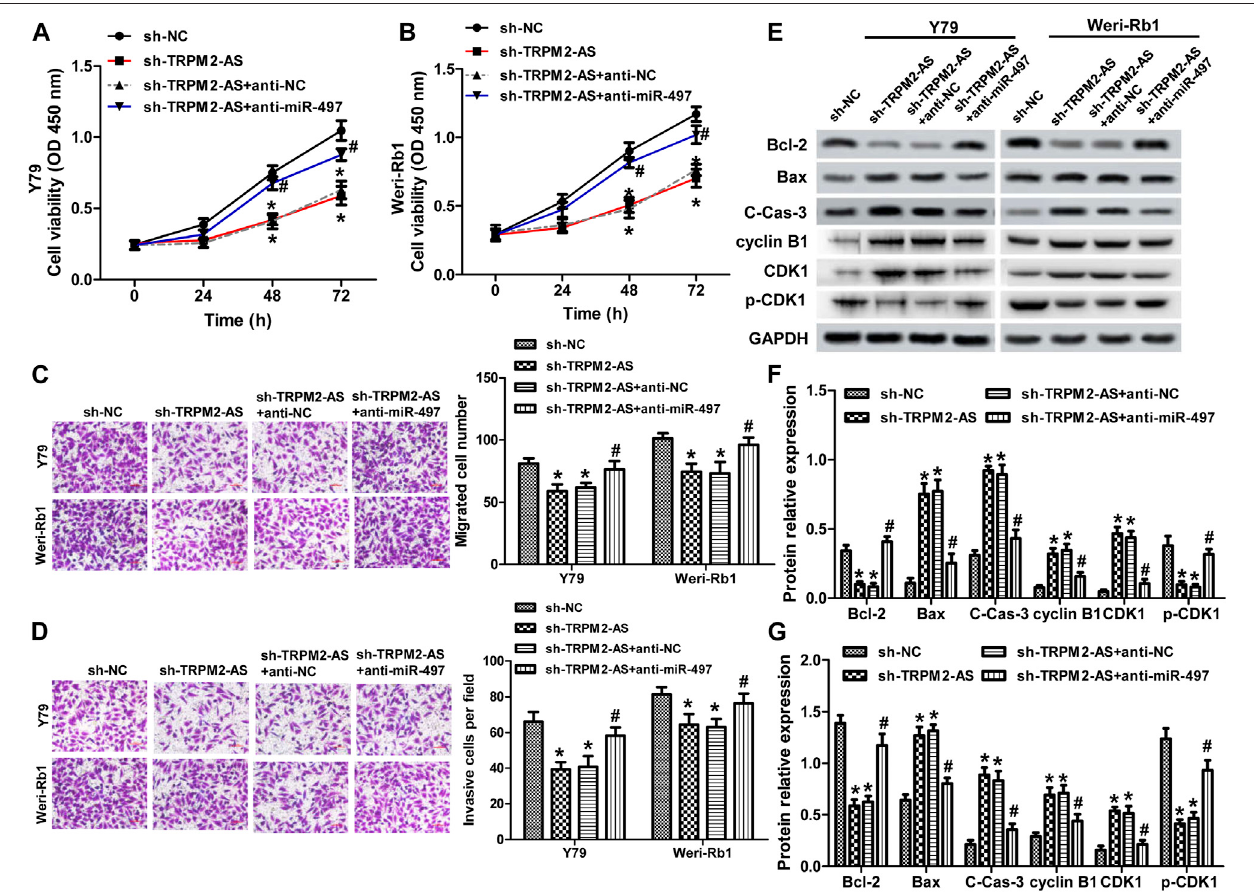
FIGURE4| miR-497inhibitorattenuatesTRPM2-ASknockdown onRBmalignantphenotypes.Y79 (A) andWeri-Rb1 (B) cellsweretransfectedwithTRPM2-AS/ control shRNA with or without miR-497/control inhibitor. And, cell proliferation was determined by CCK-8 assay. The migration (C) and invasion (D) of both RB cells under different treatments were assayed. (E – G) The protein levels of Bcl-2, Bax, cleave-caspase-3, cyclin B1, CDK1, and p-CDK1 were investigated by western blot. * p < 0.05 vs. the sh-NC group; # p < 0.05 vs. the sh-TRPM2-AS group.